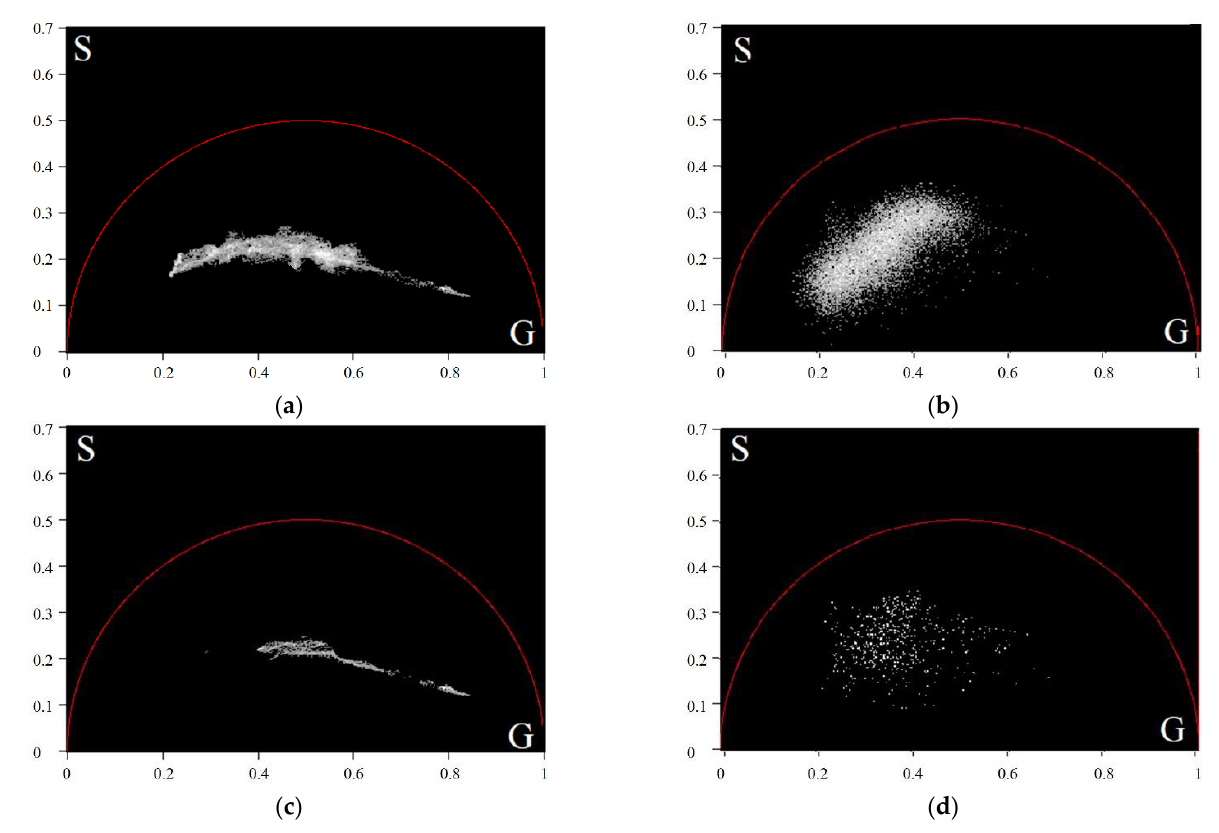
Figure 5. The phasor plots of the average TPAF lifetime t m images of the exosome samples for a CRC patient before ( a ) and after ( b ) the cutting filter processing; ( c – d ) — the same for a CP patient. The cutting filter had a threshold of 800 photons per pixel.